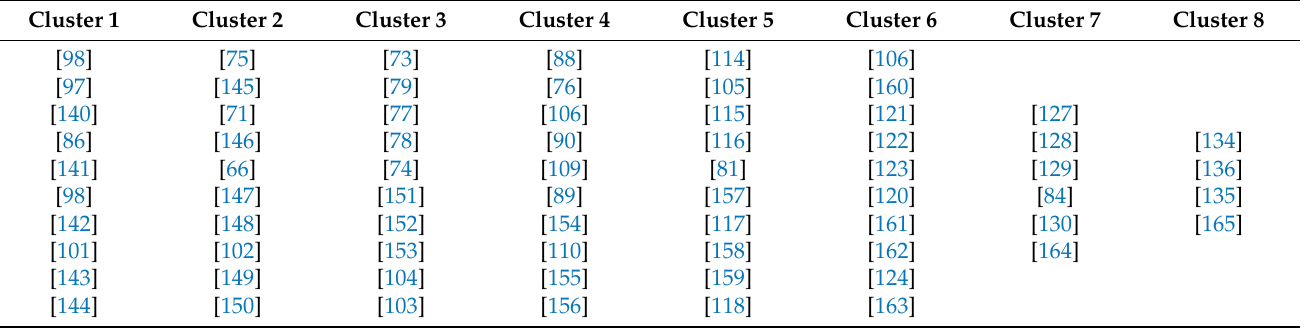
Table 10. Top 10 publications in co-citation clusters.